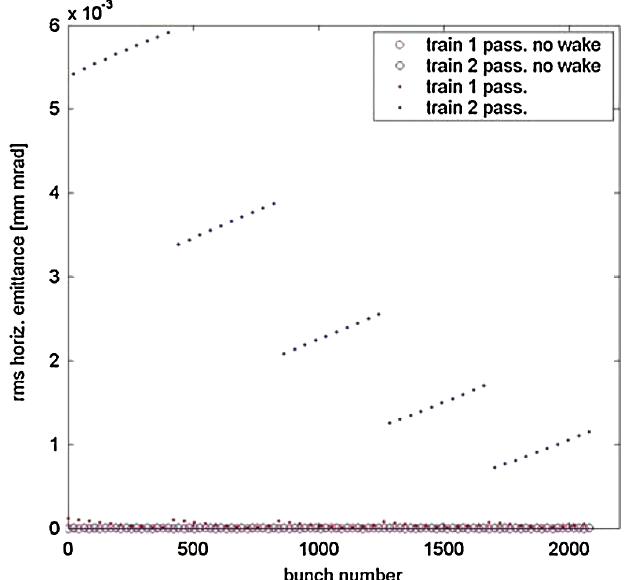
FIG. 16. (Color) The rms emittance referred to the central slice of each bunch in the case of perfect injection.